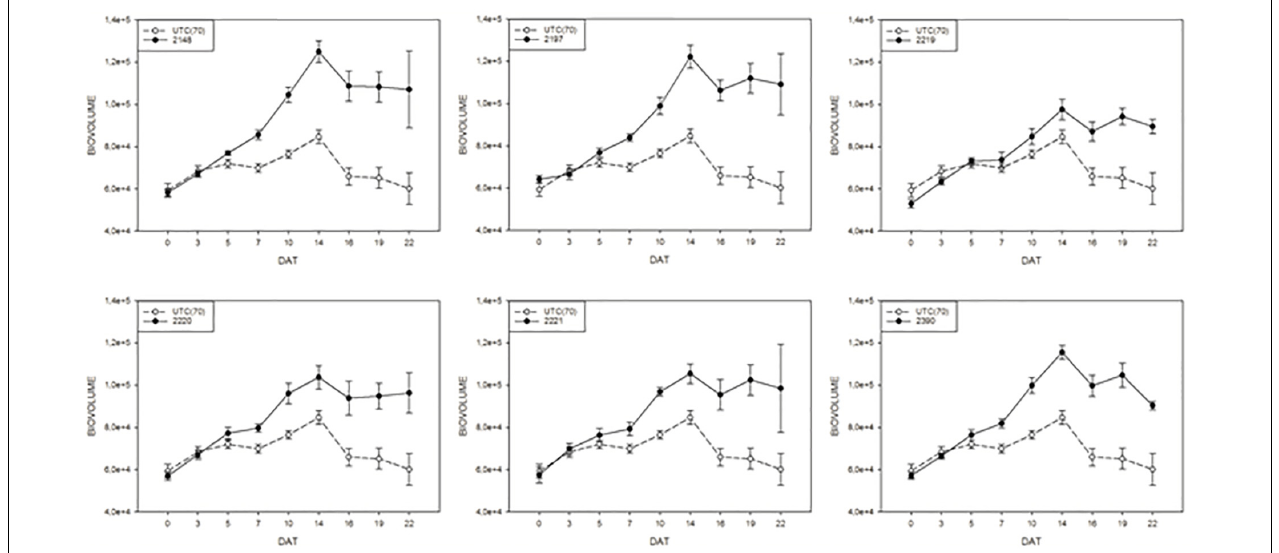
FIGURE 5 | Digital biovolume (DB) measurements on tomato plants exposed to different biostimulant prototypes: UTC(70) refers to the Untreated Control thesis where plants were irrigated with 70% FC, indicated with a dashed line. Tomato plants under reduced water condition (70% FC) and treated with the biostimulant prototypes are indicated with the solid line.